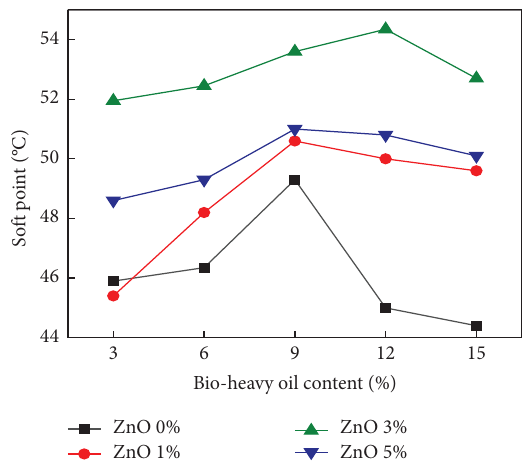
Figure 6: Te softening point of bio-asphalt with diferent